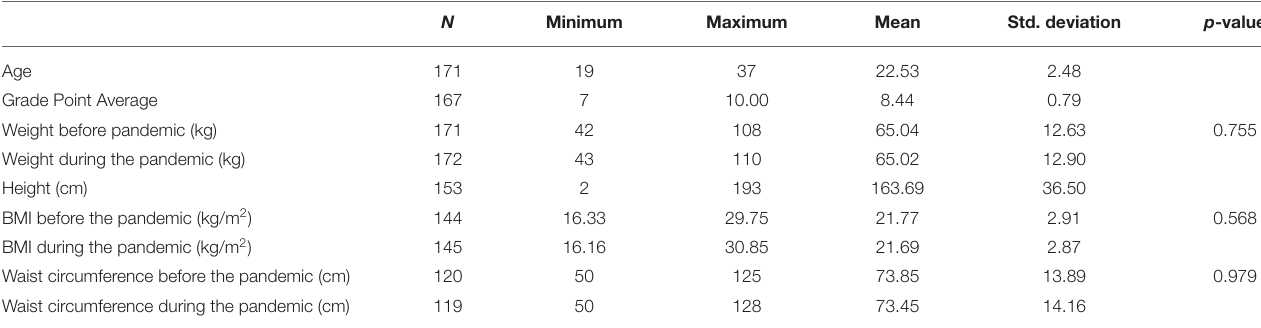
TABLE 1 | Data on age, height, weight, BMI, and waist circumference of respondents, differences before and during the COVID-19 pandemic (Wilcoxon Signed Rank test).